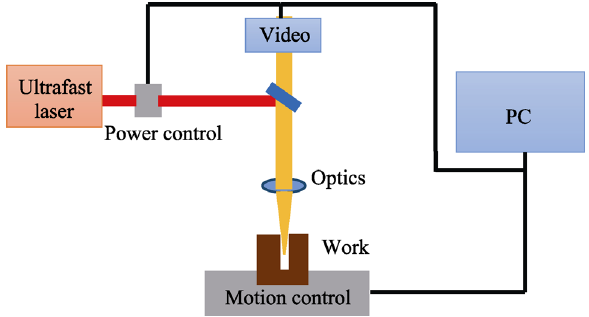
Fig. 28 Schematic diagram of laser